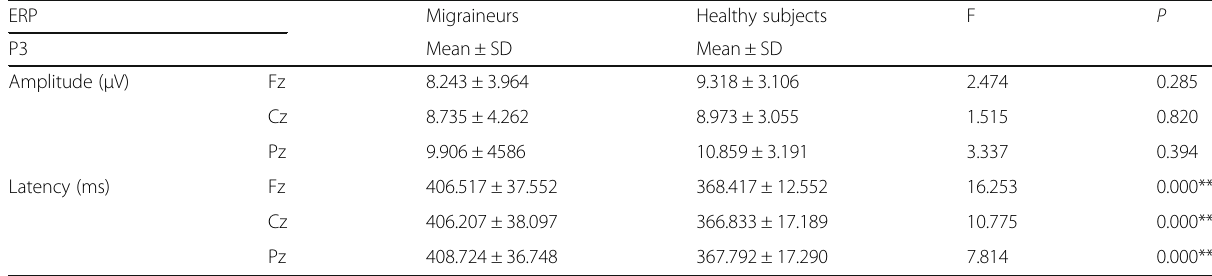
Table 3 Results of P3 amplitude and latency between migraine group and control group ERP